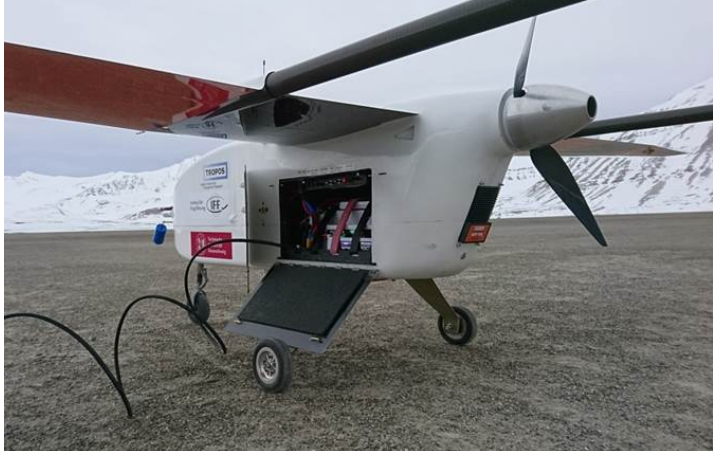
Figure 3. ALADINA during turnaround and saving data via downlink. The battery is stored in the back of the payload bay and can be removed easily by opening the side door. The full compartment was insulated. Photo: Alexander Peuker, TU